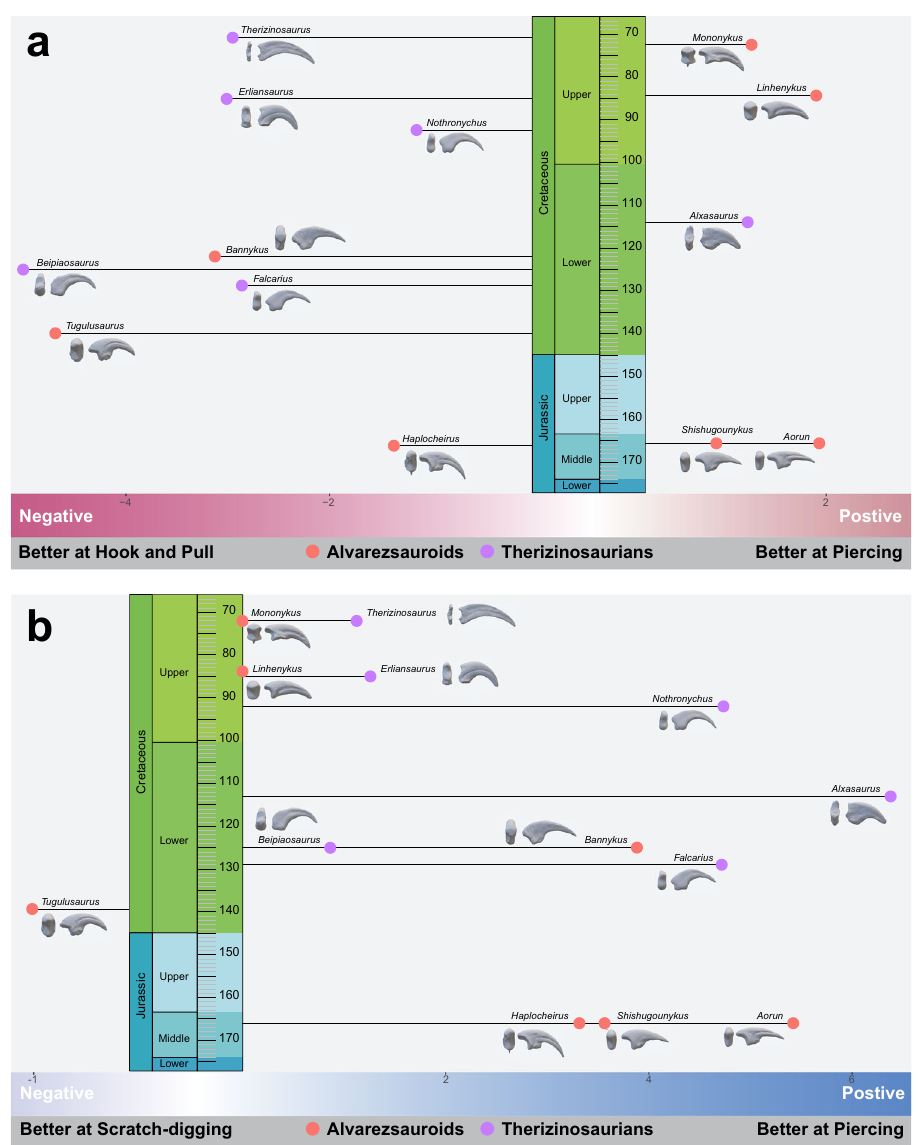
Fig. 4 Quanti fi ed manual ungual functional divergence and overall functional performance estimation though geological time scales. Functional divergences are exhibited between hook-and-pull and piercing ( a ), and scratch-digging and piercing ( b ) within alvarezsauroid and therizinosaurian